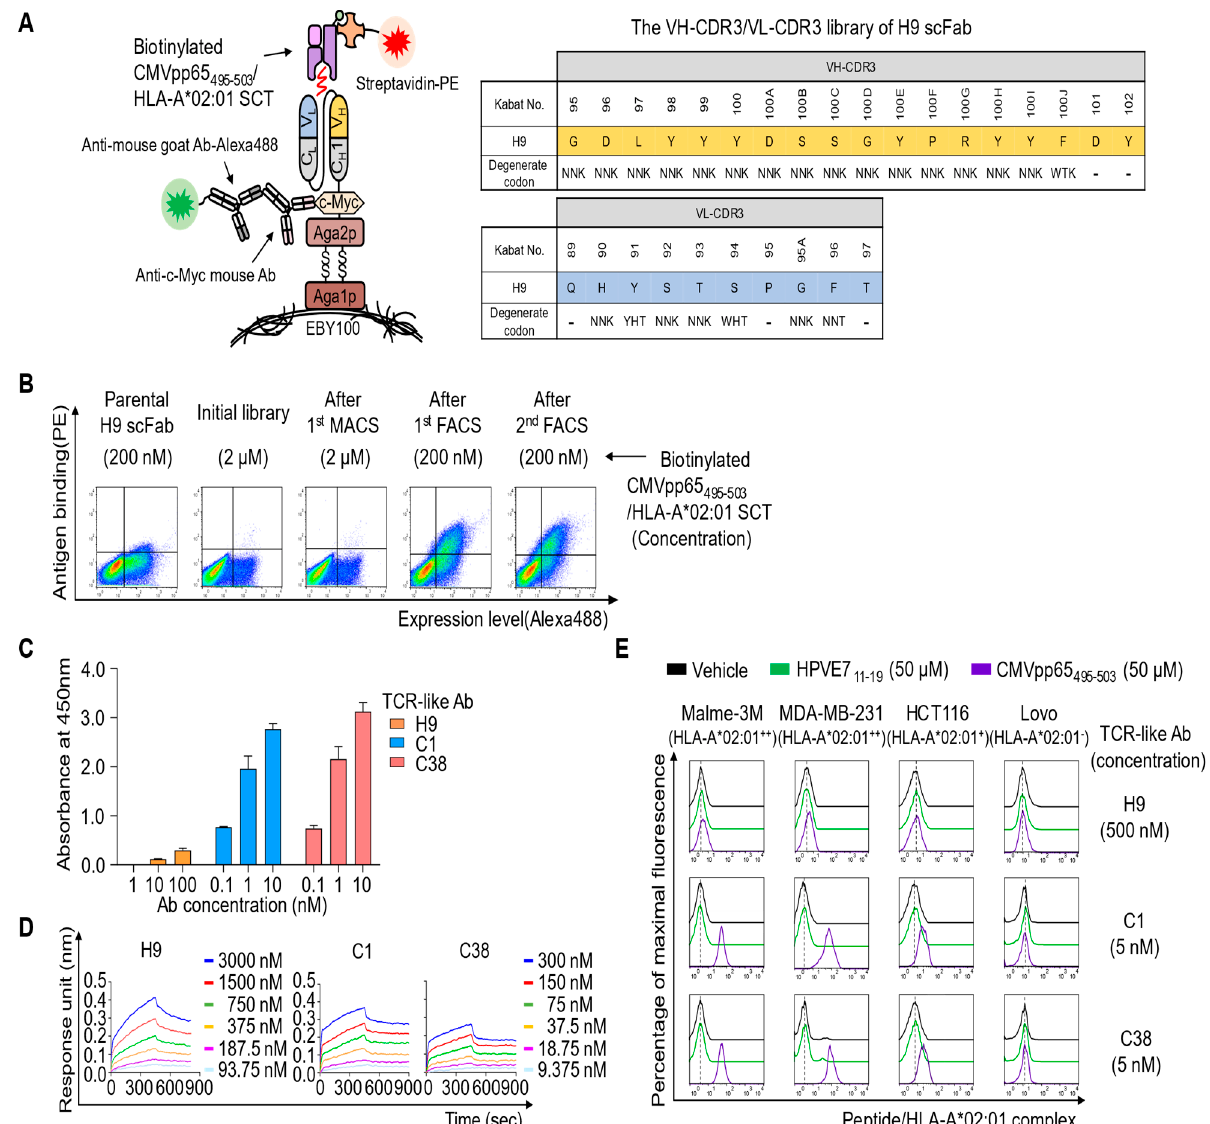
Figure 2. Affinity maturation of H9 and characterization of the isolated clones. ( A ) The scheme of library construction and screening for H9 in the single-chain antigen-binding fragment (scFab) format using YSD technology. The indicated residues in VH-CDR3 and VL-CDR3 were randomized with the indicated degenerate codons. The “-” sign denotes conserved residues.( B ) Flow cytometric analysis of antigen binding and expression levels of the yeast surface-displayed scFab library pool enriched after each round of screening by magnetically activated cell sorting (MACS) and fluorescence-activated cell sorting (FACS), compared with those of the parental H9 scFab. ( C ) Dose-dependent binding activity of the isolated and purified Abs in mouse IgG2a/ κ form toward the microtiter plate coated with peptide–MHC complex (pMHC) comprising CMVpp65 495-503 /HLA-A*02:01 single-chain trimer (SCT) antigen, as determined by ELISA. ( D ) Binding isotherms of the immobilized Abs toward the soluble CMVpp65 495-503 /HLA-A*02:01 SCT antigen, as measured by biolayer interferometry. pMHC concentrations are indicated (colored). The kinetic interaction parameters are listed in Table 1.( E ) Flow cytometric analysis of the binding of the isolated T-cell receptor (TCR)-like Abs at the indicated concentrations to the peptide-pulsed cells. Peptide pulsing and flow cytometric analysis were performed as described in Figure 1C. Representative histograms from two independent experiments are depicted.